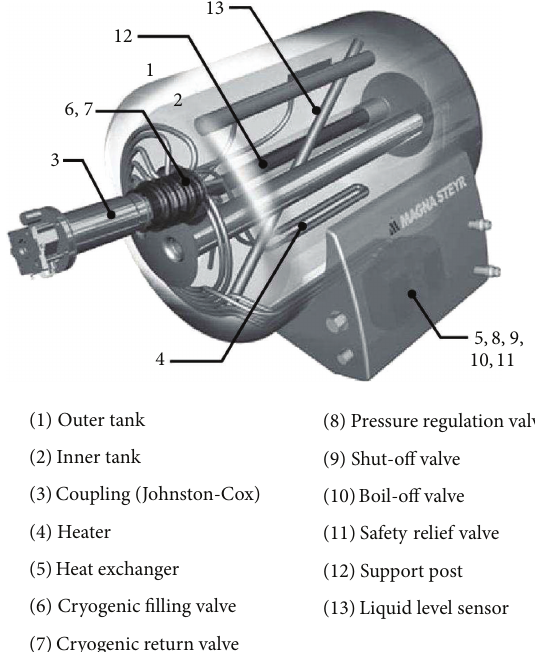
Figure 6: Schematic diagram of a liquid hydrogen tank and its components (Magna Steyr, BMW). Reprinted from [57], with per- mission from International Association of Hydrogen